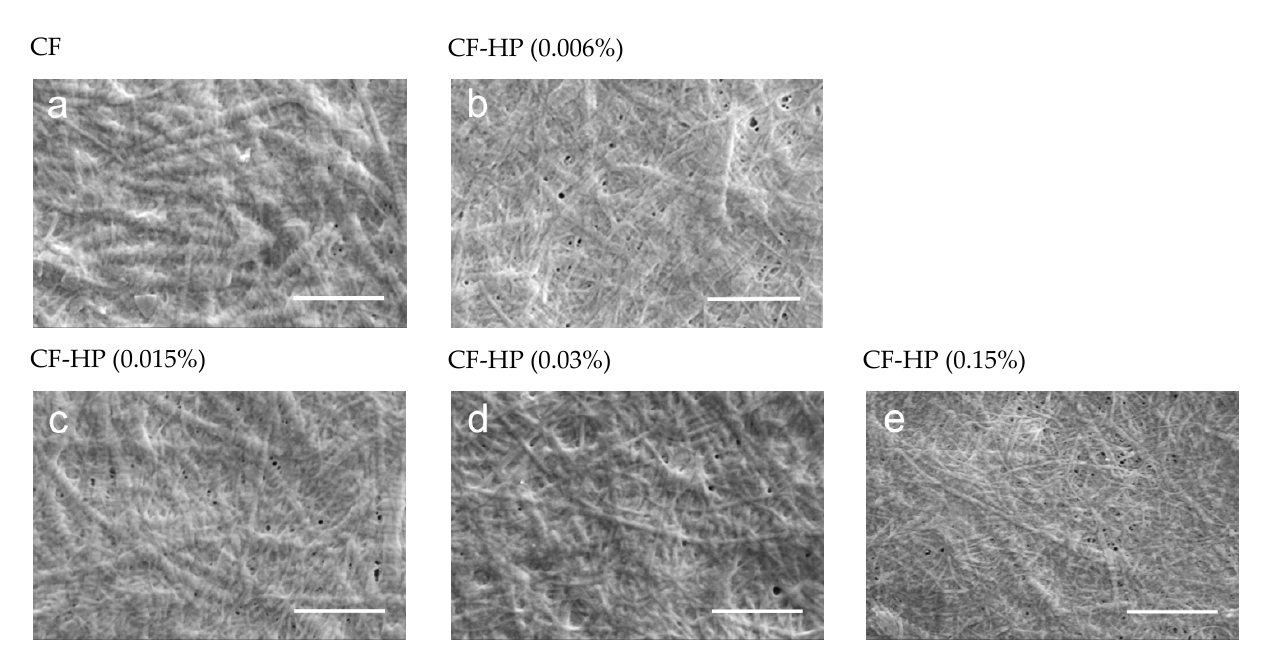
Figure 1. SEM images of collagen fibrils after different HP treatment: ( a )—collagen fibrils before treatment; ( b )—collagen fibrils after HP treatment with concentration 0.006%; ( c )—fibrils after HP treatment with concentration 0.015%; ( d )—fibrils after HP treatment with concentration 0.03%; ( e )—fibrils after HP treatment with concentration 0.15%. Scale bar 1 μ m.